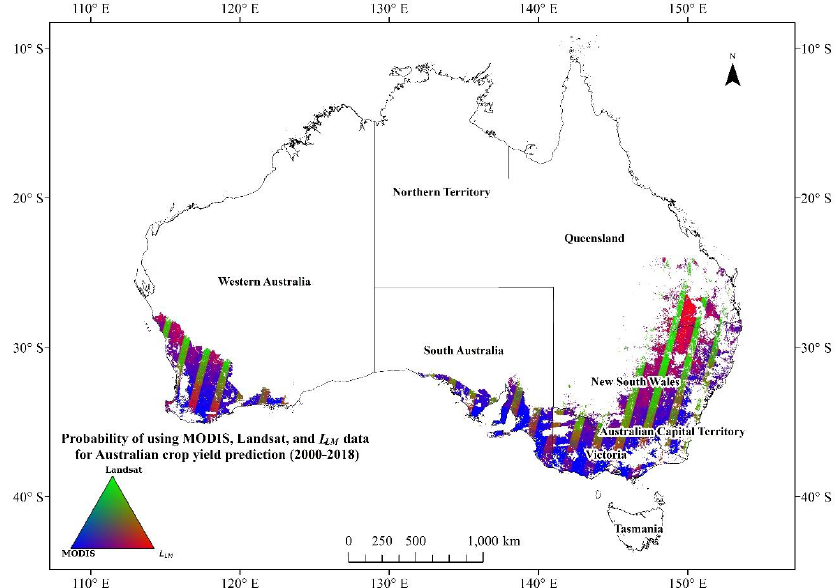
Figure 7. Multi-sensor optimal data selection across the wheatbelt (2000–2018) for 25-m pixel-level crop yield prediction, using the probability of MODIS, Landsat, and L LM images. Blue denotes regions where incomplete Landsat series have a fraction of missing data exceeding 42%, thus indicating where MODIS should be used for yield estimates because it provides more frequent observations than Landsat. Green areas show where adjacent Landsat orbits overlap and, thus, where a complete once every 16-day Landsat series over the whole growing season is available. Areas colored red are those where the fraction of Landsat missing data is below the 0.42 threshold identified previously in Figure 6 when L–M blended data improve the yield prediction